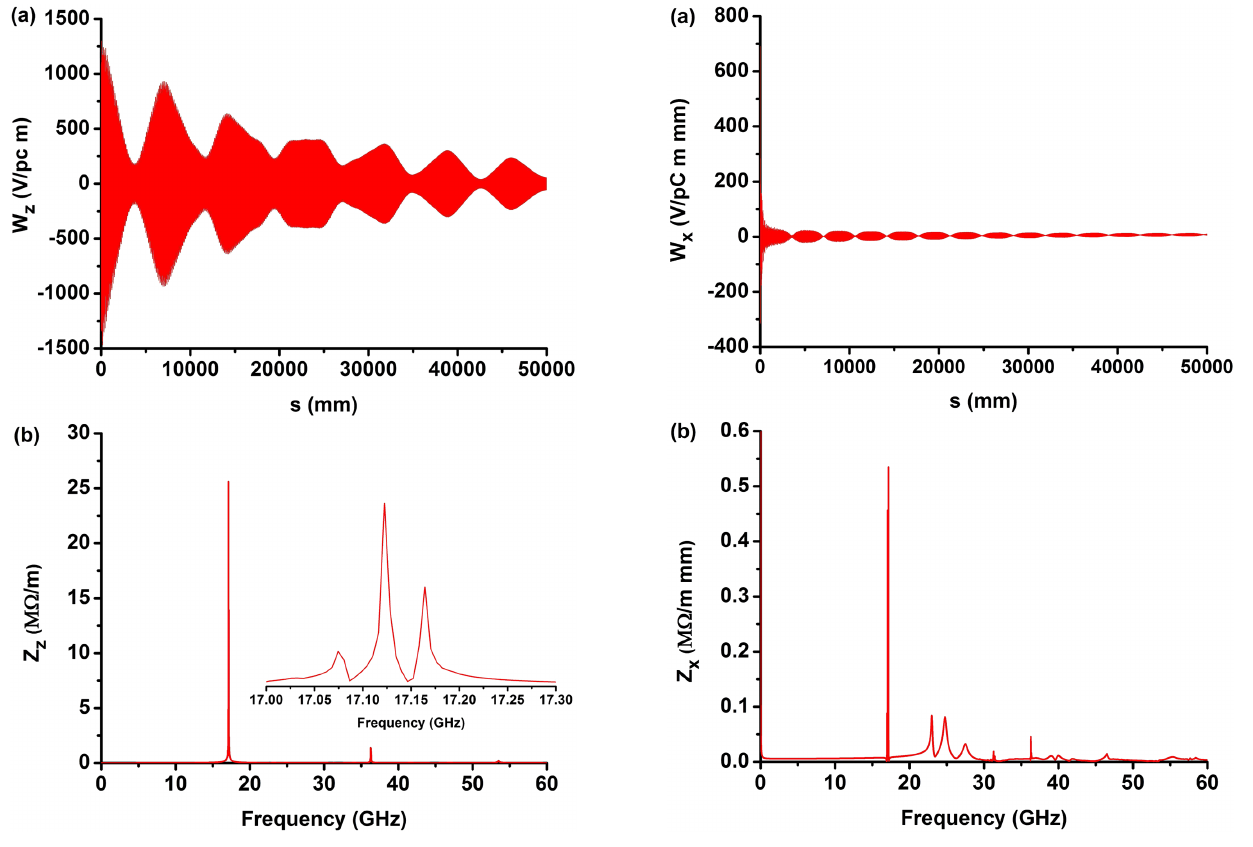
FIG. 3. Calculation of transverse wake potential and imped- ance: (a) transverse wake potential on a line parallel to the structure centerline and displaced 0.8 mm in the x direction, i.e., following the path of the beam; (b) transverse wake potential